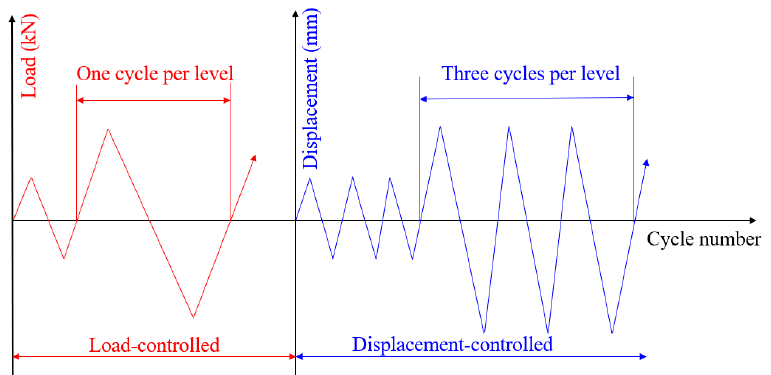
Figure 3. The assembled field loading device.